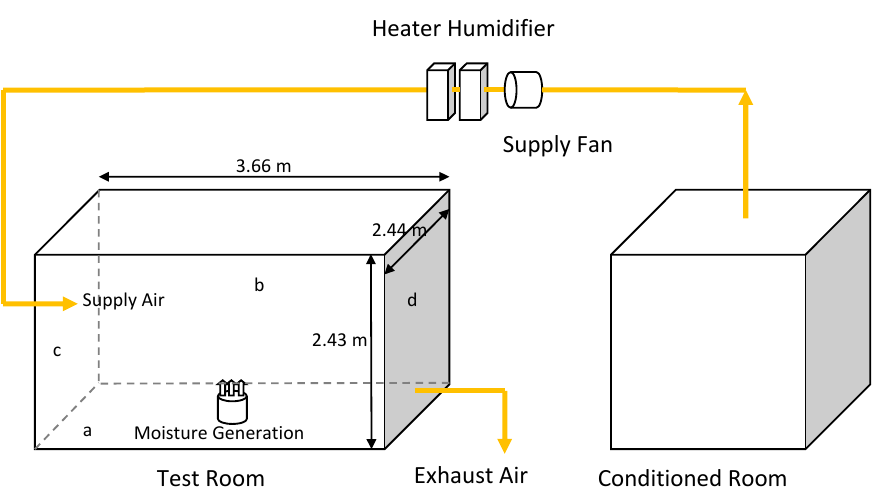
Figure 1. Model setup in BSim (dimensions are in meters).